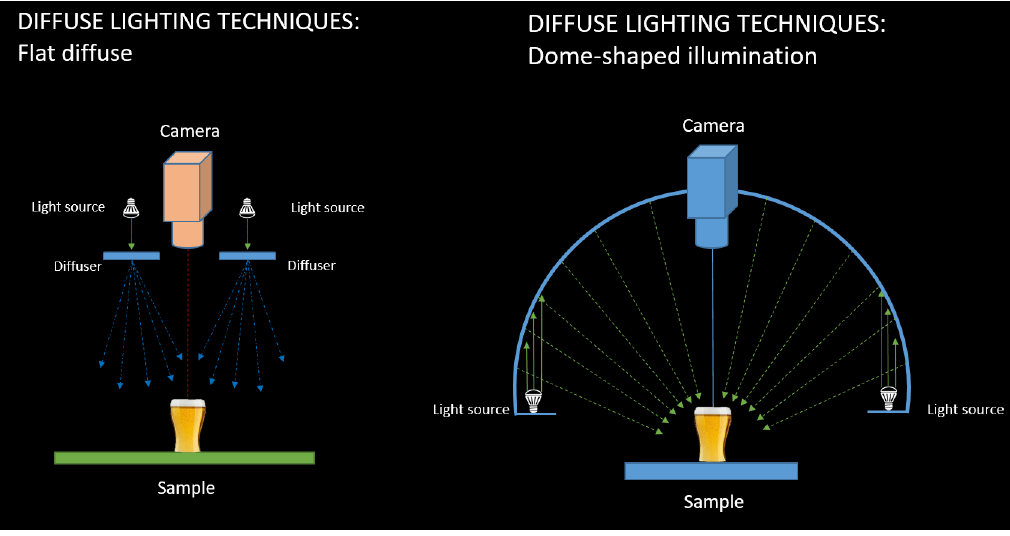
Figure 4. Diffuse lighting techniques—flat diffuse and dome shaped illumination.